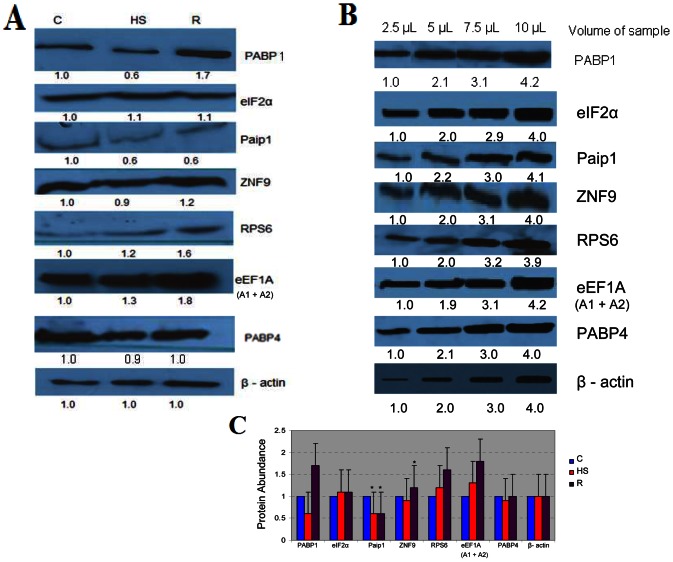
Changes in cellular level of polypeptides during heat shock and recovery.A) Cells were grown to 40% confluence and heat shocked for 3 hours at 44°C and recovered at 37°C for 24 hours. The control cells were maintained at 37°C. For all experiments cells were directly lysed on the plate using gel loading buffer, and lysates were analyzed by SDS/PAGE. Individual polypeptides were detected by western blotting using appropriate antibodies. B) Shows dose response of western blotting of cell extract from exponentially growing cells with different antibodies. The sample volumes are indicated at the top of the panel. The abundance of specific polypeptides in both panels was determined by scanning the X-ray film and quantifying the images with Image J as described in materials and methods. The values in arbitrary scale are shown bellow each lane. All values were normalized by the using the β -actin levels as loading controls. The experiment was repeated three times, and the averages are shown in panel B as mean ± standard error. C) Western blotting and quantification was performed to measure the abundance of PABP4 in control, heat- shocked and recovered cells as described above. Data are mean ± SE, p<0.05 for those with an * and p>0.05 for those that are unmarked, n = 3.